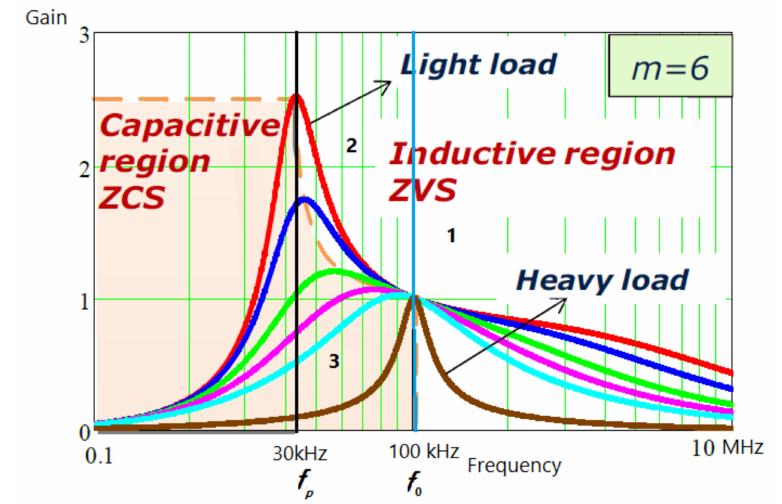
Figure 3. The characteristics of the LLC resonant converter